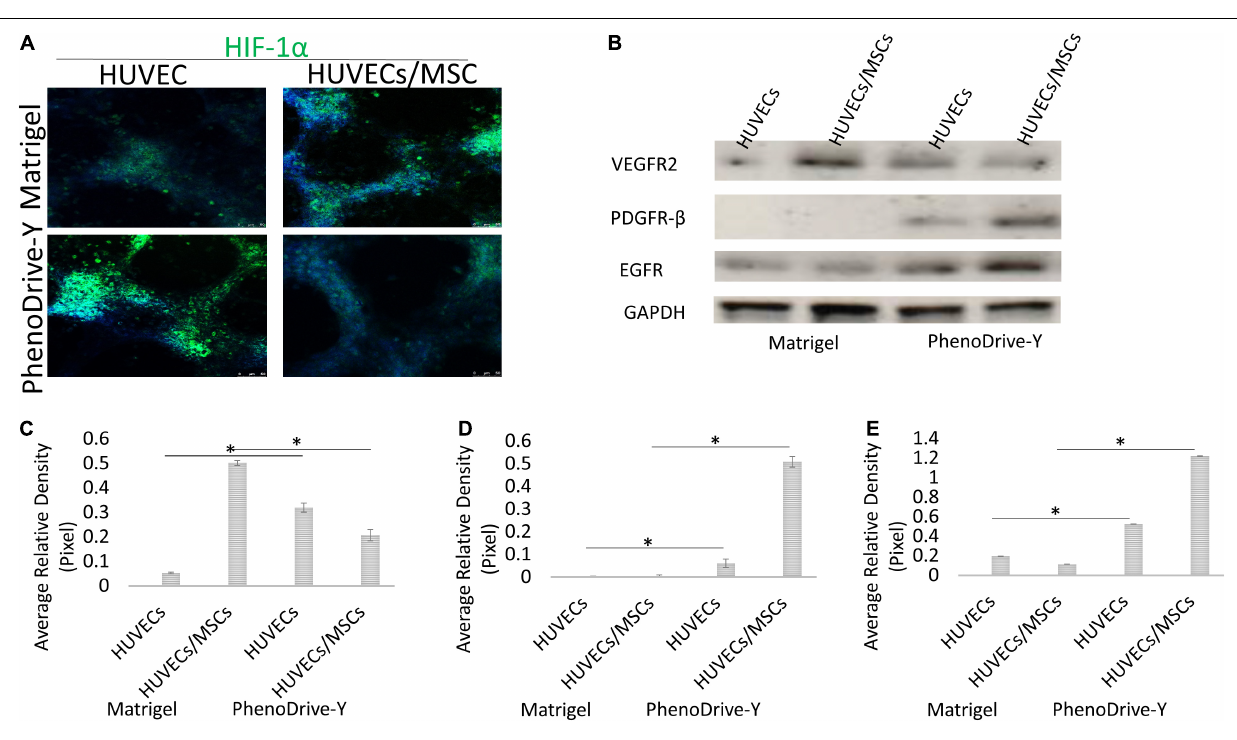
Frontiers in Cell and Developmental Biology |